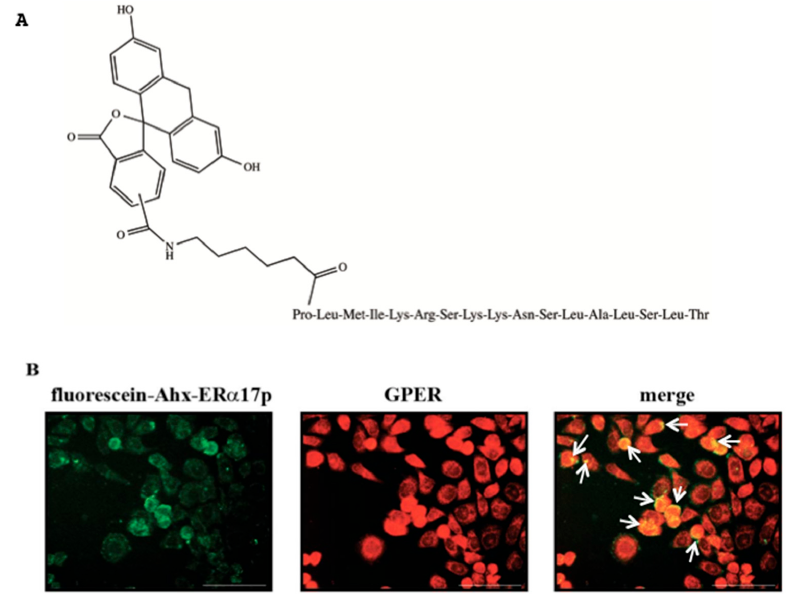
Figure 3. Fluorescence signal of the fluorescein-labeled peptide (carboxyfluorescein-Ahx-ER α 17p). ( A ) Structure of the peptide ER α 17p labeled at the C-terminus with Ahx (spacer) and carboxyfluorescein. The peptidic part of the molecule is written using the three letter code. ( B ) SkBr3 cells treated for 5 min with the peptide carboxyfluorescein-Ahx-ER α 17p (10 µ M, green signal, left) or immunostained with the anti-GPER antibody (red signal, middle). The overlay of the peptide carboxyfluorescein-Ahx-ER α 17p and GPER signals generates the merge signal (in yellow) visualized in the right panel by white arrows. Each experiment is representative of 20 random fields observed in each of three independent experiments.